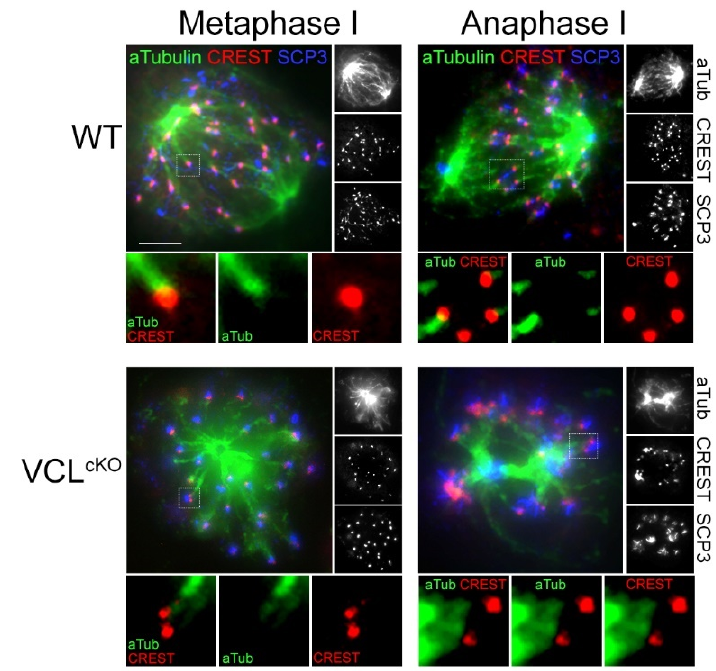
Figure 6. VCL cKO kinetochores were not attached to the meiotic spindle. Metaphase I stage in WT control showed attachment of the kinetochore to the microtubule filament of the meiotic spindle. During anaphase I, sister kinetochores were pulled toward the spindle poles. In the VCL cKO spermatocytes, kinetochores of the bivalent appeared with the spit CREST foci, and microtubule filaments tried to reach each of them (two microtubule filaments, detail on the left). In anaphase I, VCL missing kinetochores was not aligned to the equatorial zone but remain scattered around non-standard meiotic spindle.